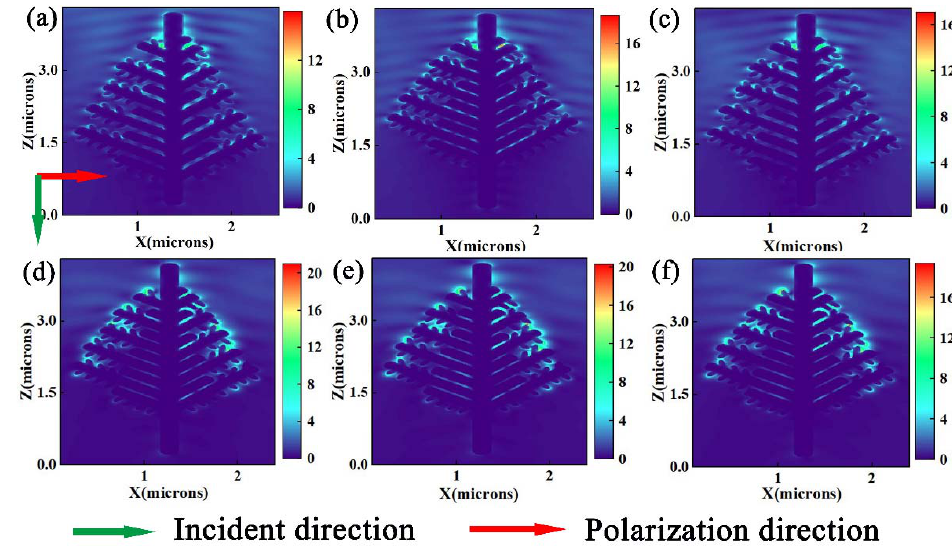
Figure 4. FDTD simulates the electric field distribution of different substrate structures. 3D Ag substrate: ( a , b ) the distances between adjacent branches were 80 nm and 40 nm, respectively. 3D Au– Ag substrate: ( c , d ) 60 nm Au particles were constructed on the basis of ( a , b ) structures respectively, ( e , f ) 90 nm and 120 nm Au particles were constructed on the basis of ( b ) structures.